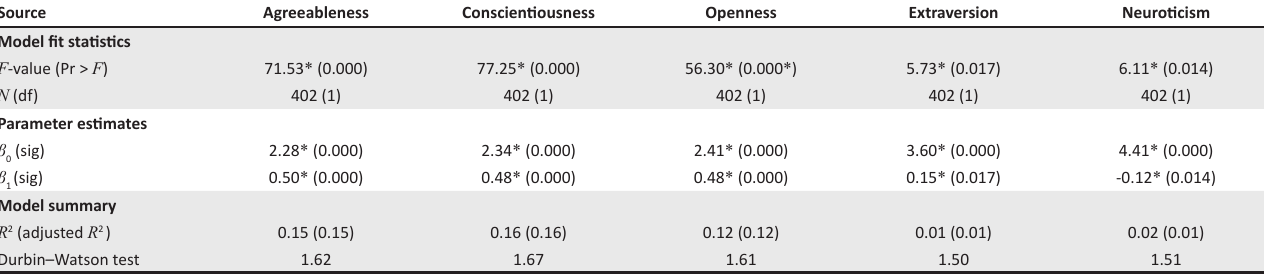
TABLE 5: Simple linear regression model fit and summary for the big five personalities on job engagement.